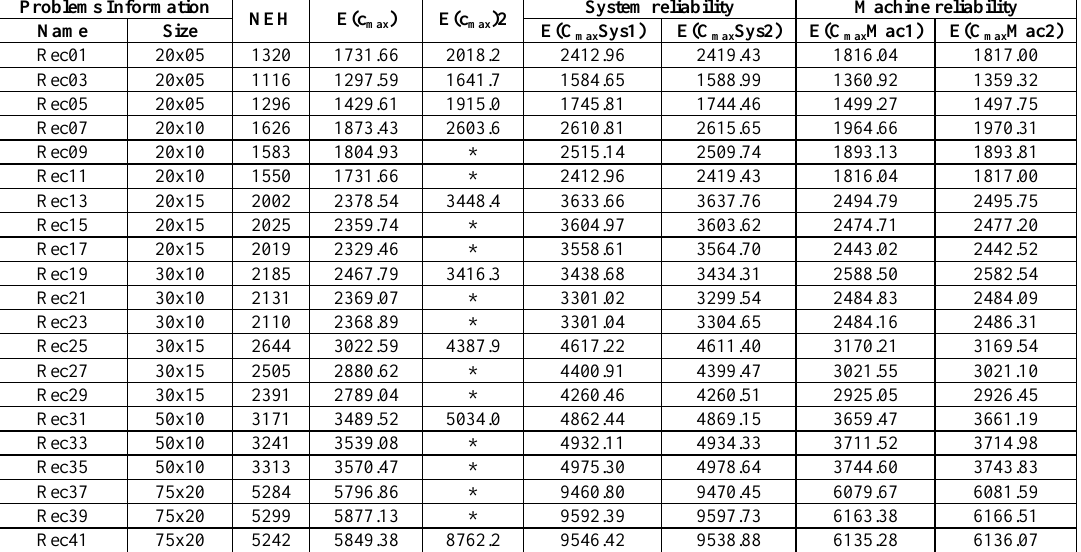
Table 4. Computational results for rec problems exponentially